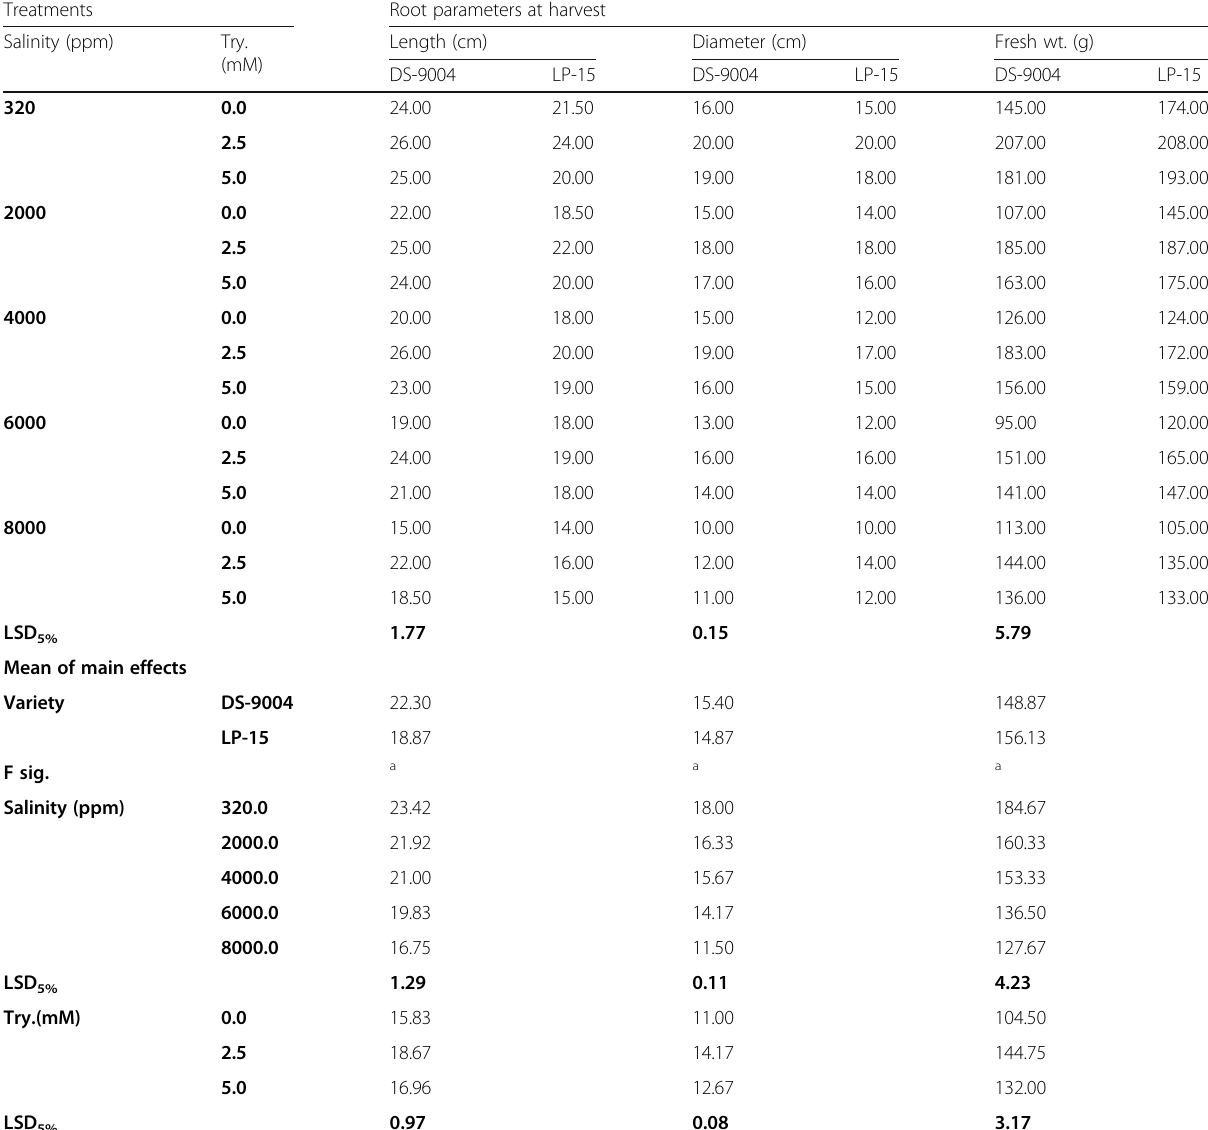
Table 4 Effect of soaking two sugar beet seed cultivars with tryptophan and irrigated with different salinity levels on root parameters at harvest (180 days after sowing) Treatments Root parameters at harvest Salinity (ppm) Try.